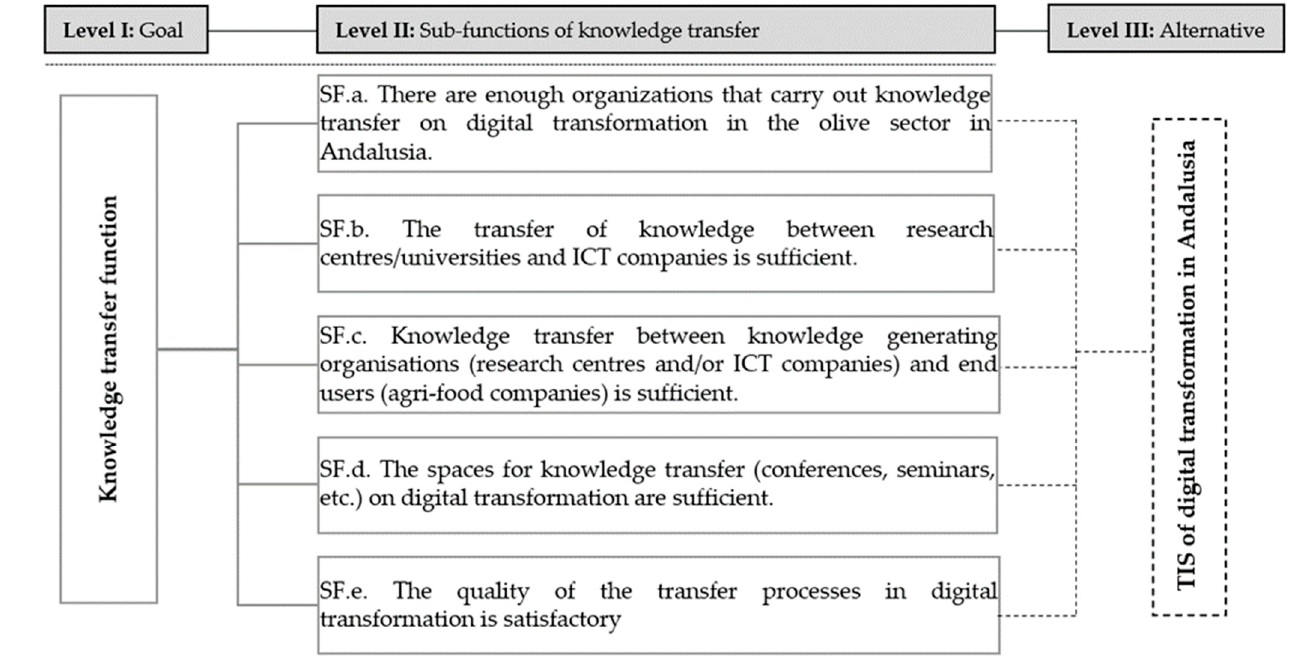
Figure 1. AHP model for the KT function performance of the TIS of DT in the Andalusian olive landscape.